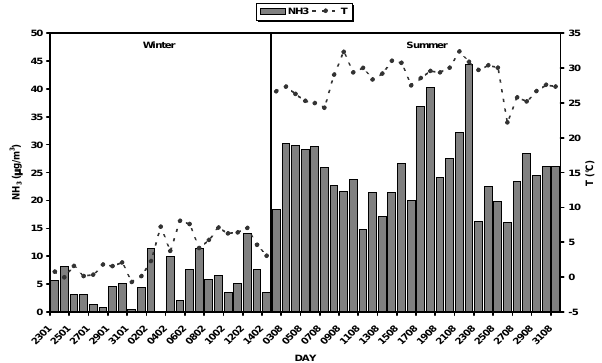
Fig. 1. Temporal trend of ammonia during the winter and summer campaigns at Beijing.